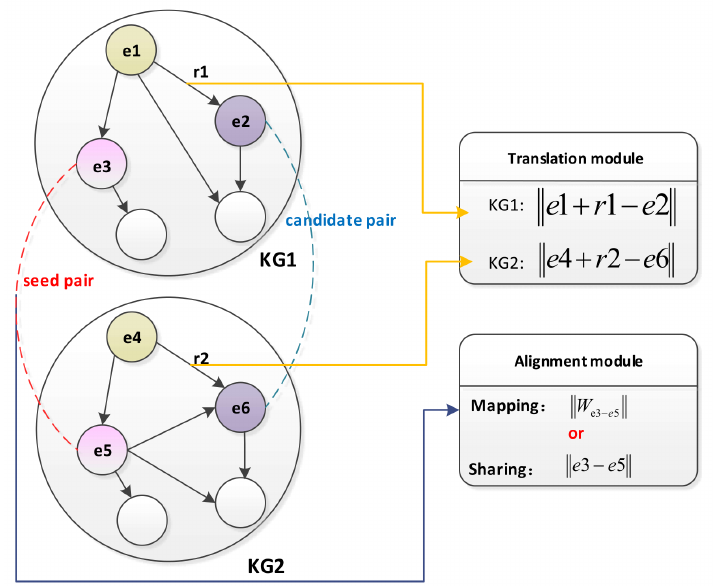
Figure 2. An example of the description of triple entities in